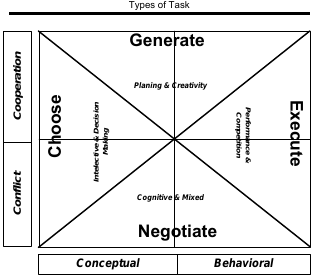
Figure 2 . Task types for learning, adapting from McGrath